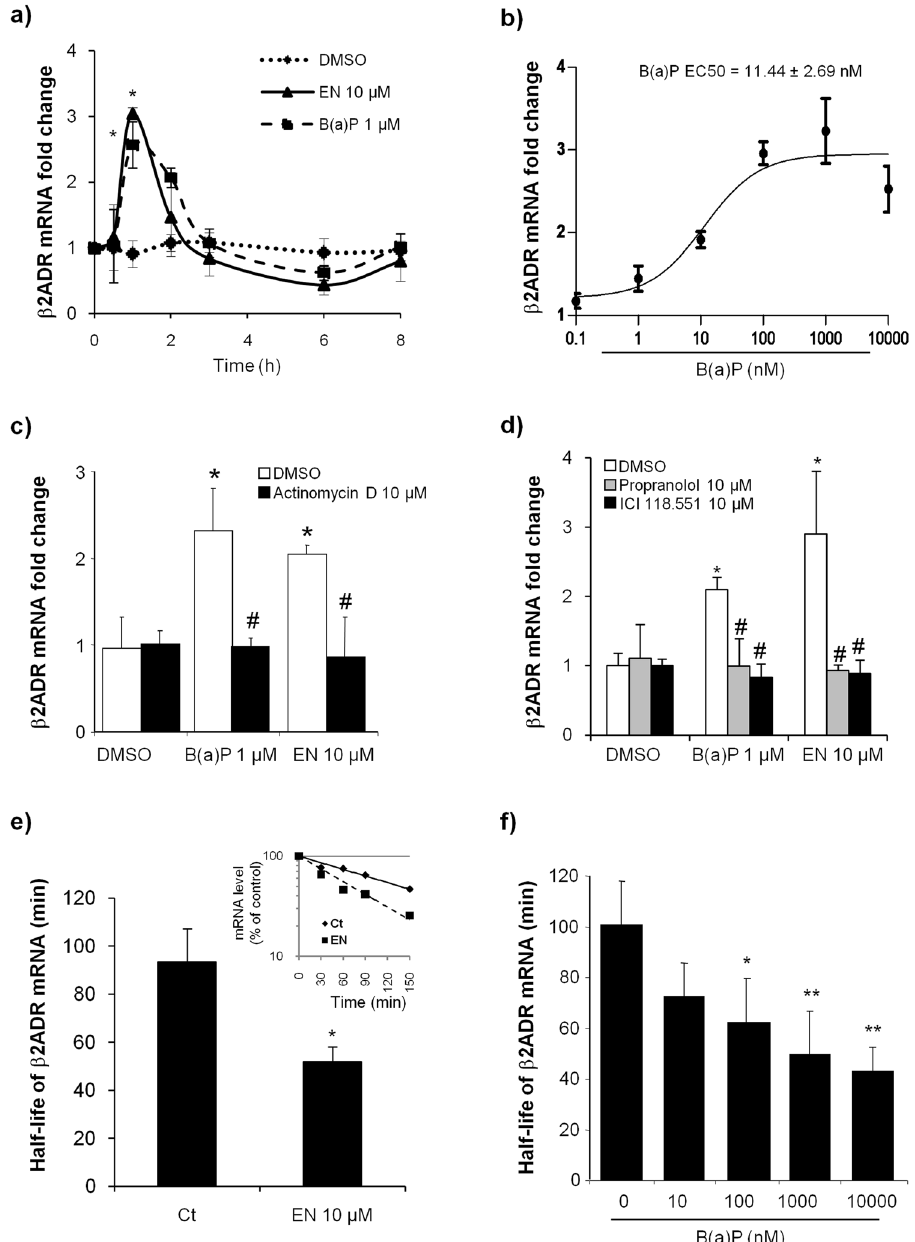
Figure 4. B(a)P exposure influenced β 2ADR mRNA level. ( a ) HMEC-1 cells were exposed to 10 µ M EN, 1 µ M B(a)P or vehicle (DMSO) for indicated times before analyzing β 2ADR mRNA expressions by RT-qPCR. Data are expressed relatively to mRNA levels found in corresponding control cells, arbitrarily set to 1 unit, and are the means ± S.D of at least three independent assays. * p < 0.05 when compared to corresponding control cells. ( b ) HMEC-1 cells were exposed to indicated concentrations of B(a)P or vehicle (DMSO) for 1 h. mRNA expressions of β 2ADR were then analyzed by RT-qPCR. Data are expressed relatively to mRNA levels found in control cells, arbitrarily set to 1 unit, and are the means ± S.D of at least three independent assays. ( c , d ) HMEC-1 cells were exposed to 10 µ M EN, 1 µ M B(a)P or vehicle (DMSO) for 1 h, in the presence or absence of 10 µ M actinomycin D ( c ), or in the presence or absence of 10 µ M propranolol or 10 µ M ICI 118.551 ( d ). mRNA expressions of β 2ADR were then analyzed by RT-qPCR. Data are expressed relatively to mRNA levels found in corresponding control cells, arbitrarily set to 1 unit, and are the means ± S.D of at least three independent assays. * p < 0.05 when compared with conotrol cells. # p < 0.05 when compared to EN- or B(a)P-treated counterparts. ( e , f ) HMEC-1 cells were either untreated or exposed (1 h) to 10 µ M EN ( e ), or were exposed to indicated concentrations of B(a)P or vehicle (DMSO) ( f ), Half-lives of β 2ADR mRNA were then calculated as described in Materials and Methods section. Data correspond to mRNA half-lives, expressed in minutes, and are the means ± S.D of three independent assays. * p < 0.05 when compared with untreated cells. # p < 0.05 when compared to EN- or B(a)P-treated counterparts. Representative curves of mRNA decay kinetics in the absence (Ct) or presence of EN are given in the insert ( e